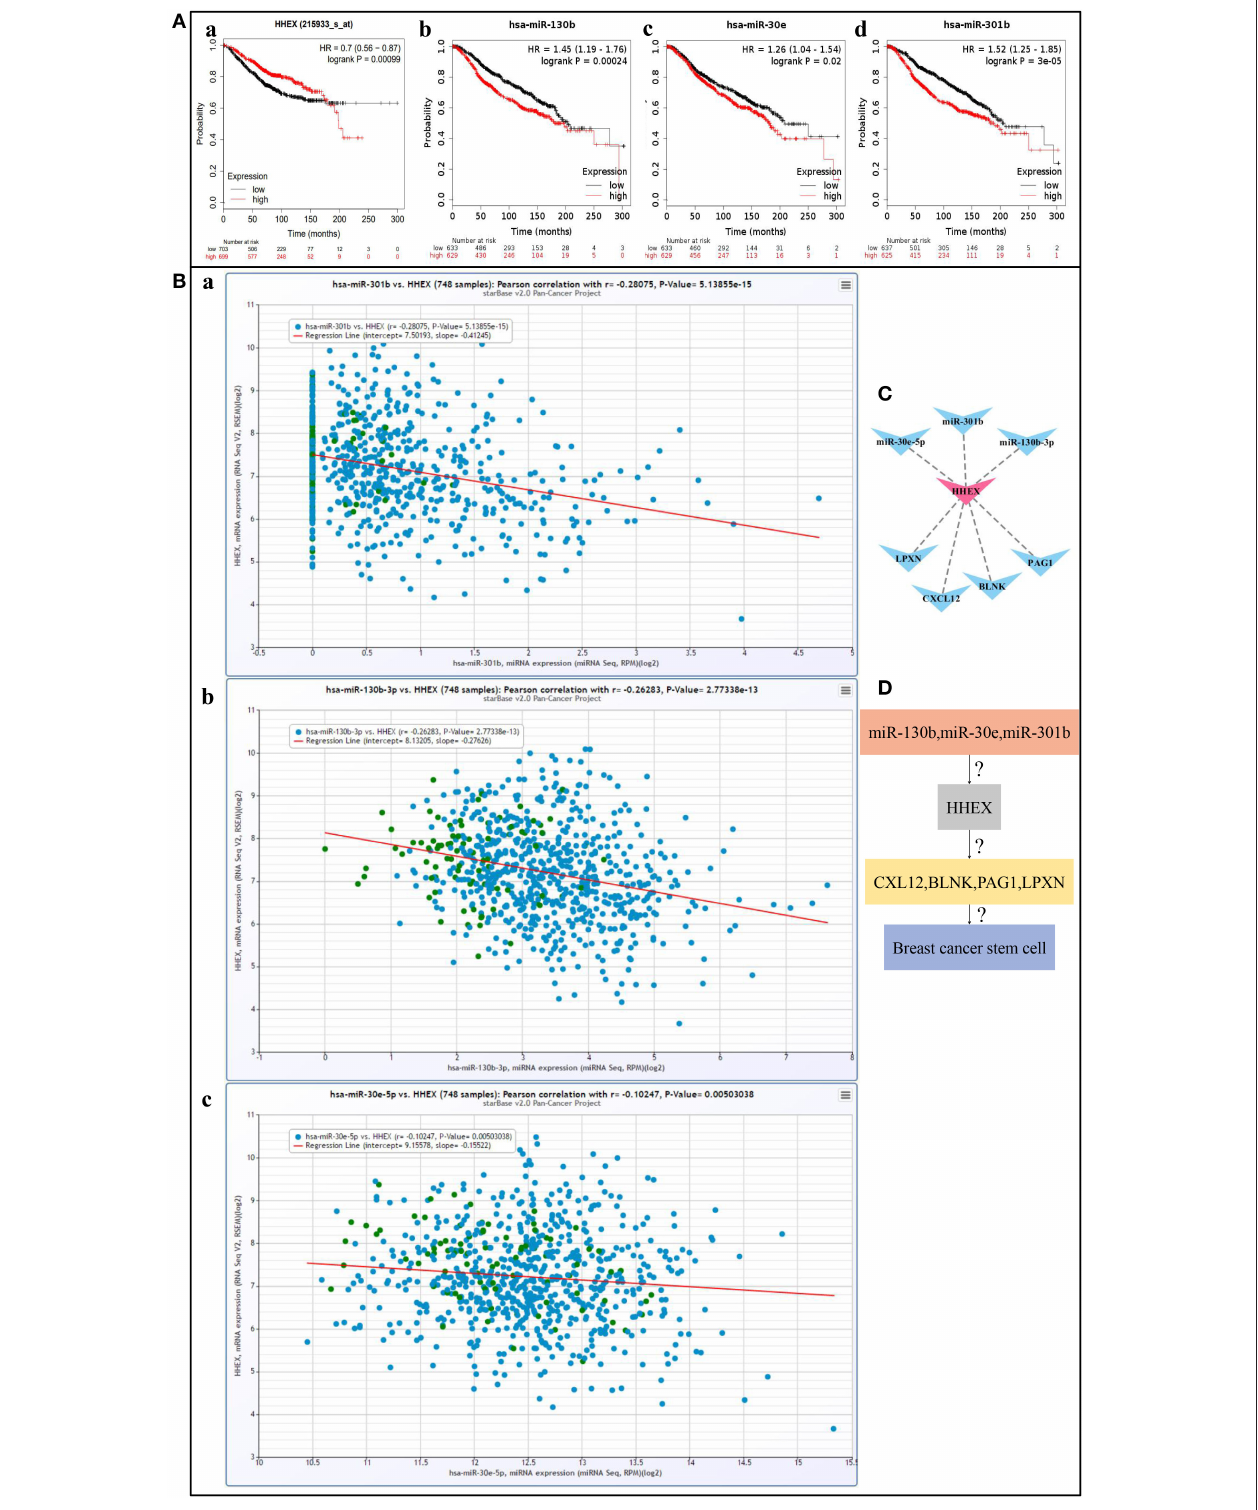
FIGURE 6 | miRNA-HHEX-mRNA potential regulatory mechanism of HHEX in breast cancer (BC). (A) Overall survival curves of HHEX, miR-130b, miR-30e, and miR-301b in BC patients determined using Kaplan–Meier plotter. (B) The negative correlation between HHEX expression and miR-130b, miR-30e, and miR-301b by StarBase. (C) The miRNA-HHEX-mRNA potential regulatory network was constructed using Cytoscape. (D) The potential regulatory mechanism of HHEX in BC.